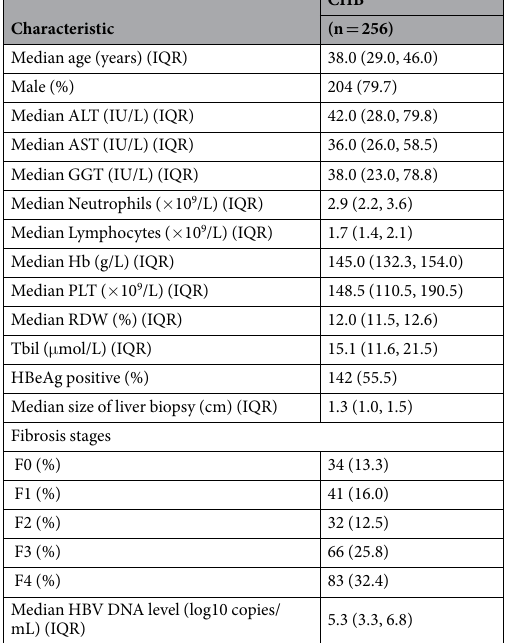
Table 1. Baseline characteristics of the study population. ALT, alanine aminotransferase; AST, aspartate aminotransferase; CHB, chronic hepatitis B; GGT, gamma-glutamyl transferase; Hb, hemoglobin; IQR, interquartile range; PLT, platelets; RDW, red cell distribution width; Tbil, total